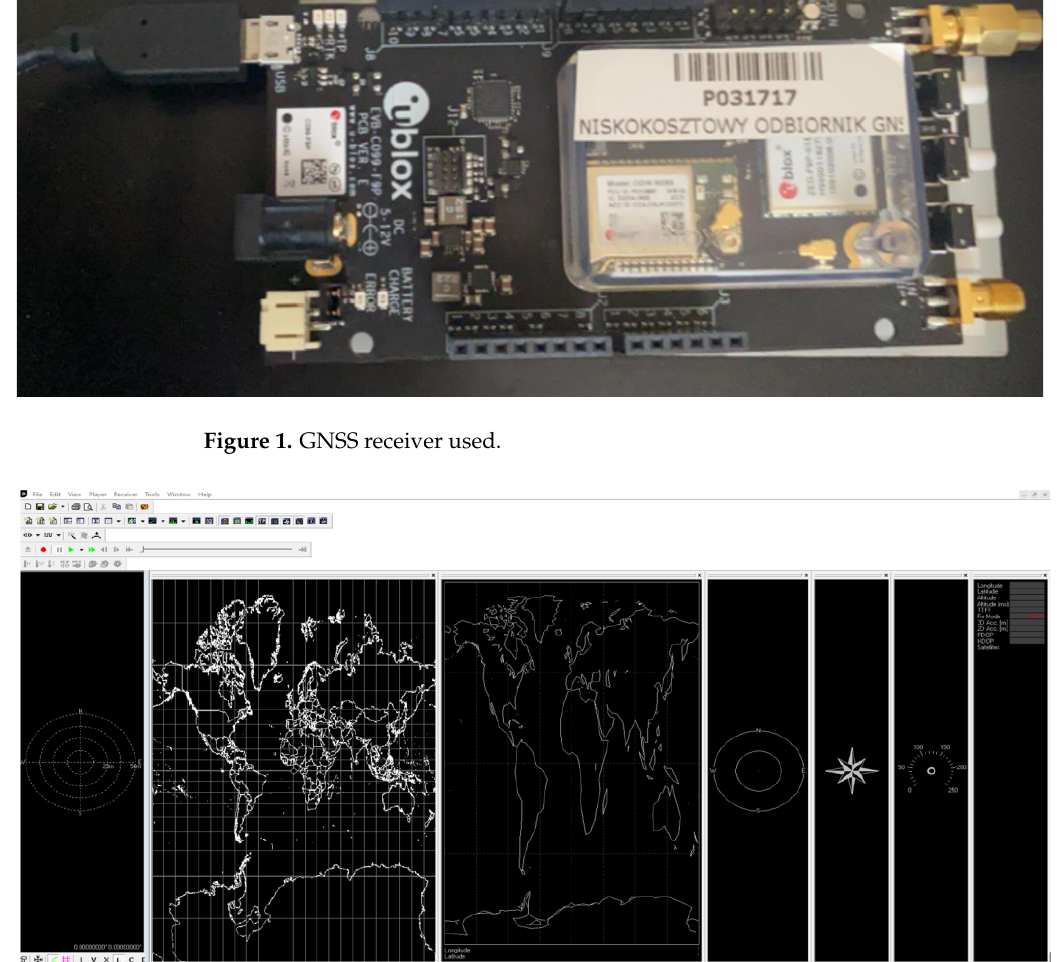
Figure 1. GNSS receiver used.